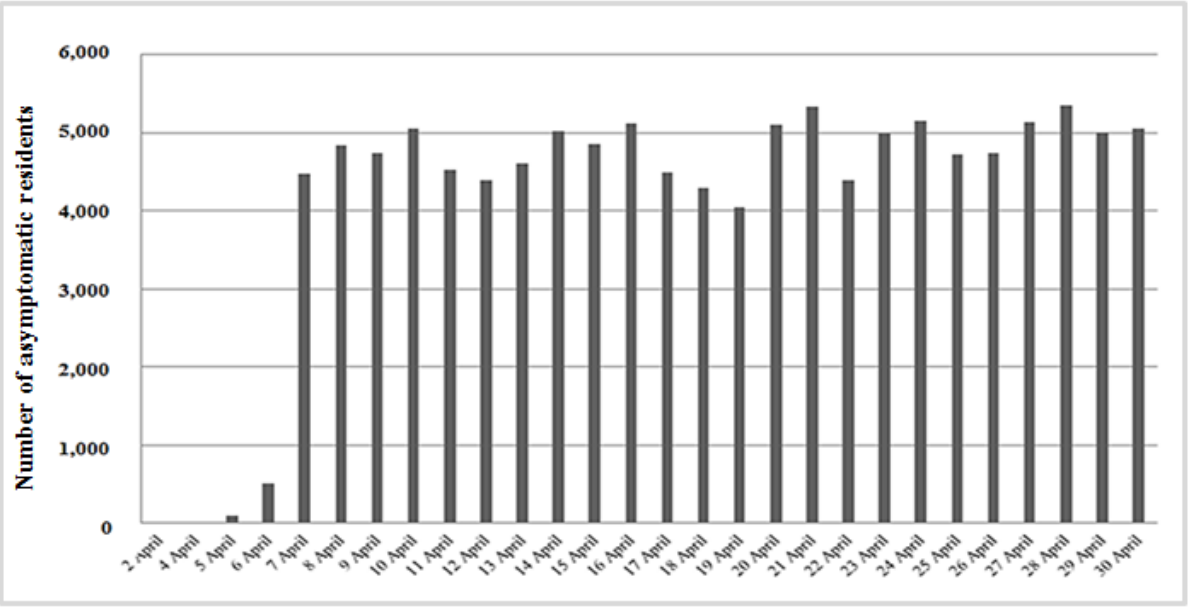
Figure 2. Numbers of residents who were asymptomatic for coronavirus disease for more than 14 days as reported by long-term care facility health care staff through COVIDApp over 30